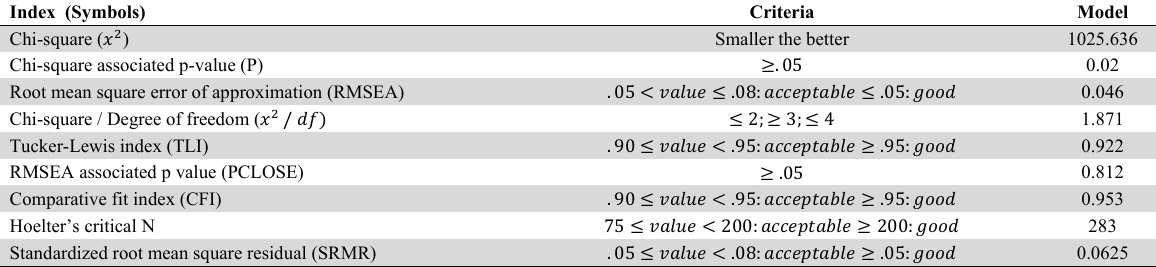
Goodness-of-fit statistics for Structural Equation